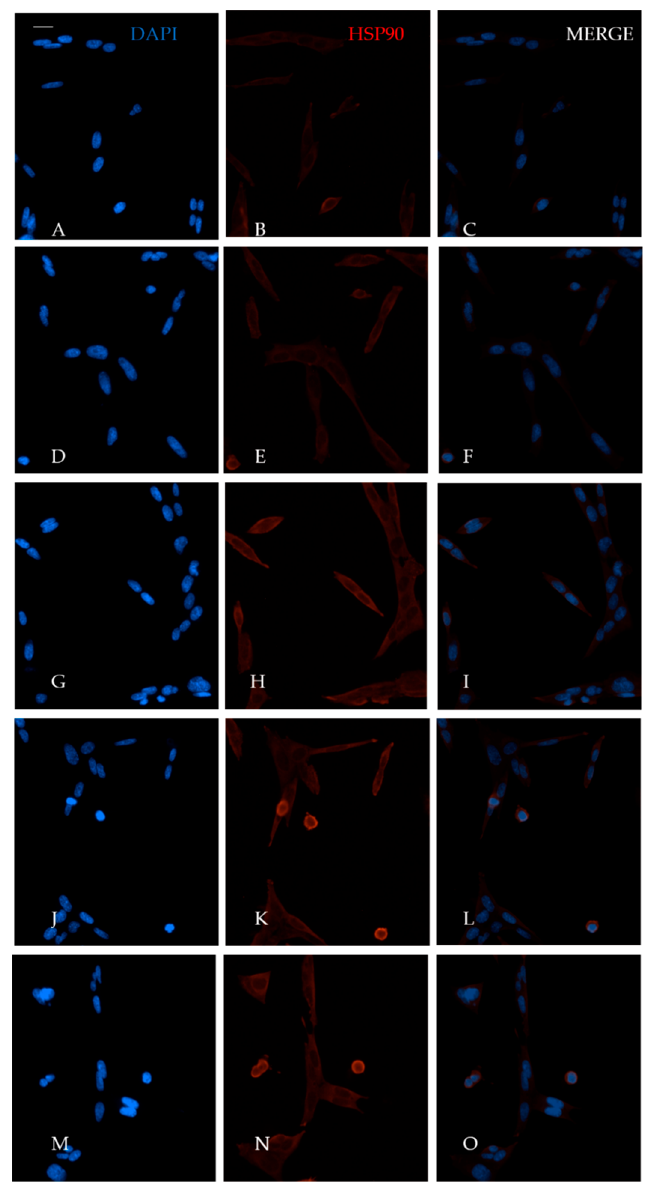
Figure 3. Immunofluorescence analysis of HSP90 expression in CT2A maintained during 1 h and 30 min at 5% CO 2 and di ff erent temperatures (Microscope 20 × ): ( A ) 37 ◦ C CT2A nuclei staining with DAPI; ( B ) 37 ◦ C CT2A HSP90 expression; ( C ) merge of A and B; ( D ) 37.5 ◦ C CT2A nuclei staining with DAPI; ( E ) 37.5 ◦ C CT2A HSP90 expression; ( F ) merge of D and E. ( G ) 38 ◦ C CT2A nuclei staining with DAPI; ( H ) 38 ◦ C CT2A HSP90 expression; ( I ) merge of G and H. ( J ) 38.5 ◦ C CT2A nuclei staining with DAPI; ( K ) 38.5 ◦ C CT2A HSP90 expression; ( L ) merge of J and K. ( M ) 39 ◦ C CT2A nuclei staining with DAPI; ( N ) 39 ◦ C CT2A HSP90 expression; ( O ) merge of M and